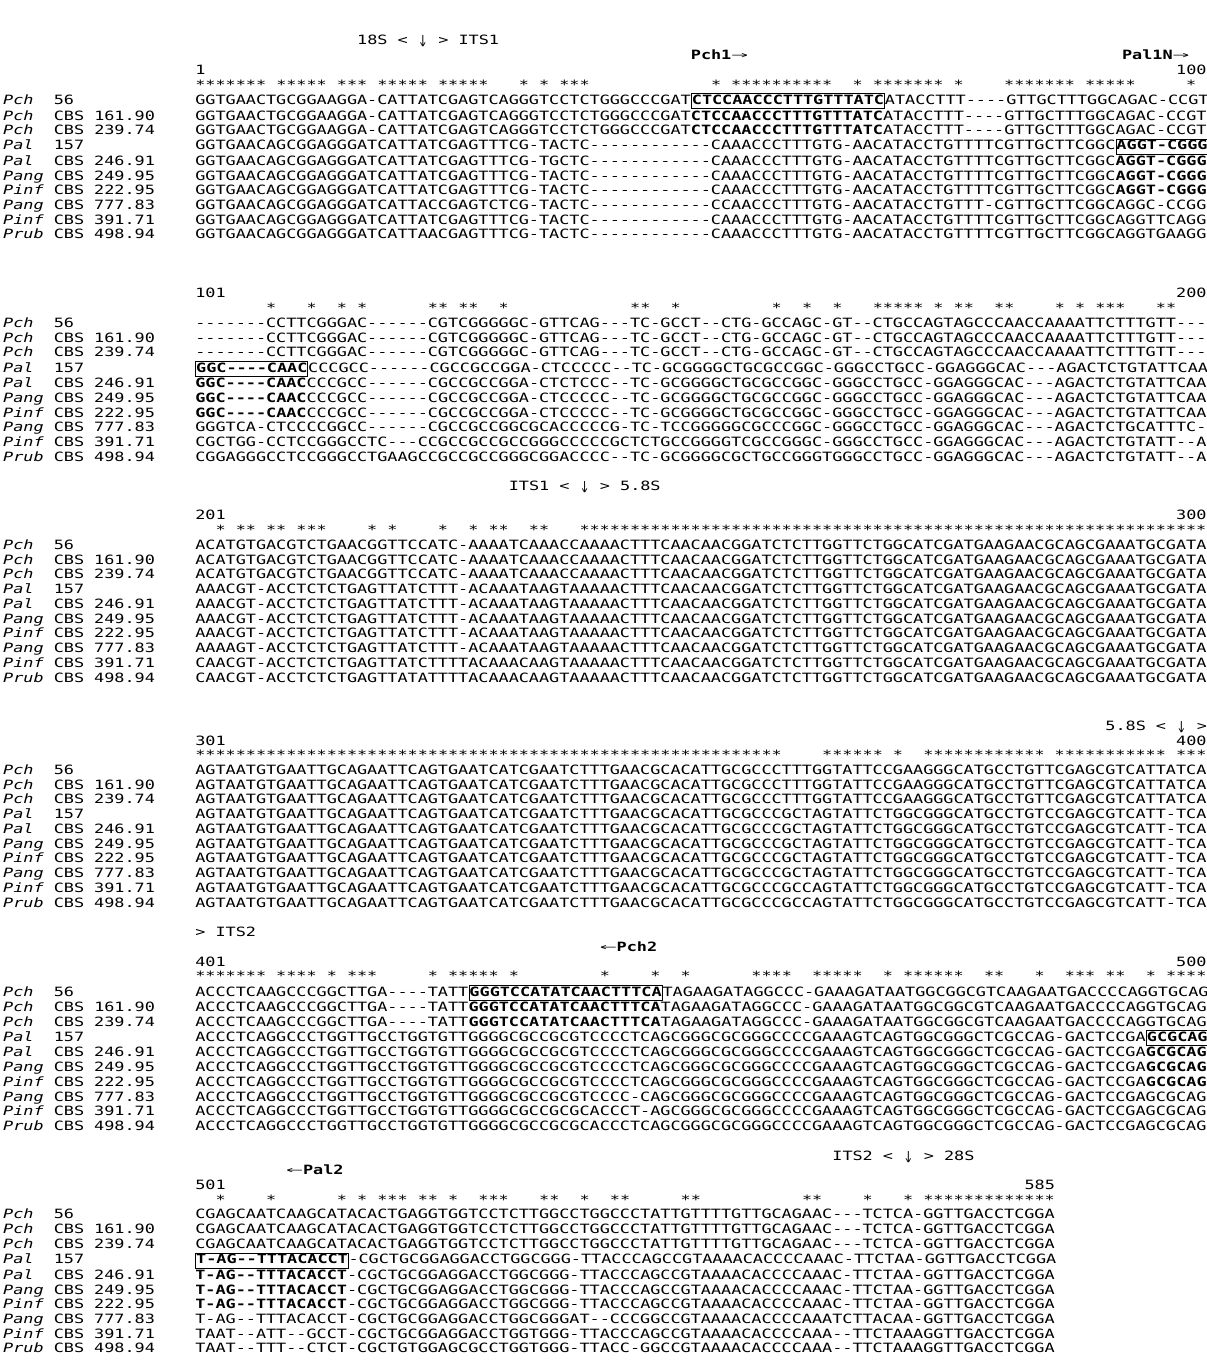
Fig. 2. Multiple alignment ITS1-5.8S-ITS2 sequences, plus small portions of 3’ end of 18S and of 5’ end of 28S rDNA, of five Phaeoacremonium species. The start (>) and the end (<) of the ITS1, ITS2 and 5.8S are indicated, as are the end of the 18S and the start of 28S rDNA. In the aligned sequences, asterisk = match, dash= gap. The localization of the primer pairs Pal1N-Pal2 and Pch1-Pch2 designed for the detection of P.aleophilum and P. chlamydosporum , respectively, are indicated by large blocks. Bold characters indicate the annealing sites for both the pairs. The sense of each primer is in accordance to the arrow reported above the sequences. Abbreviations: Pch, P. chlamydosporum ; Pal, P. aleophilum ; Pang, P. angustius ; Pinf, P. inflatipes ; Prub, P.